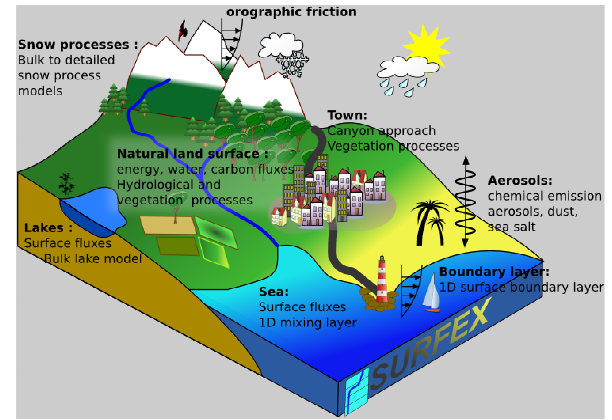
Figure 1. Schematic representations of the main processes and functionalities of SURFEX. 3 Fig. 1. Schematic representations of the main processes and func- tionalities of